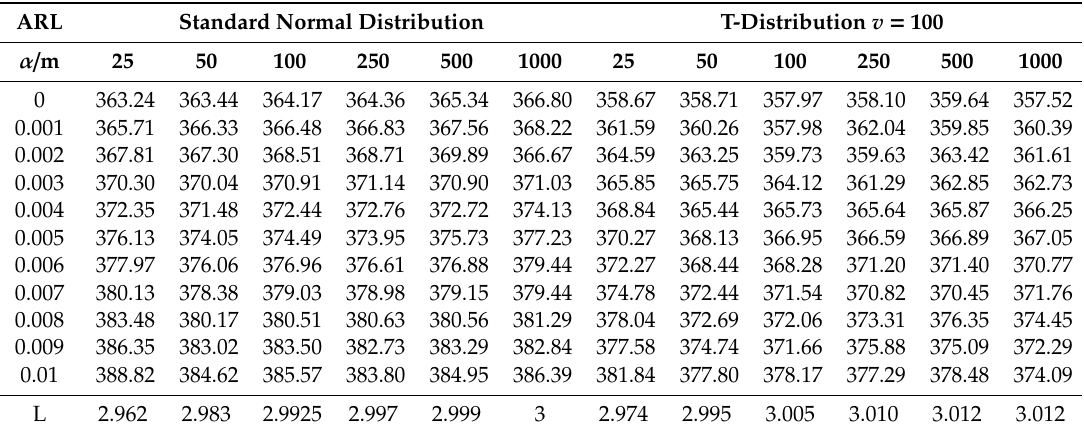
Table 5. ARL of the Shewhart chart with Tukey outlier detection for standard normal and t ( v = 100) distributions.